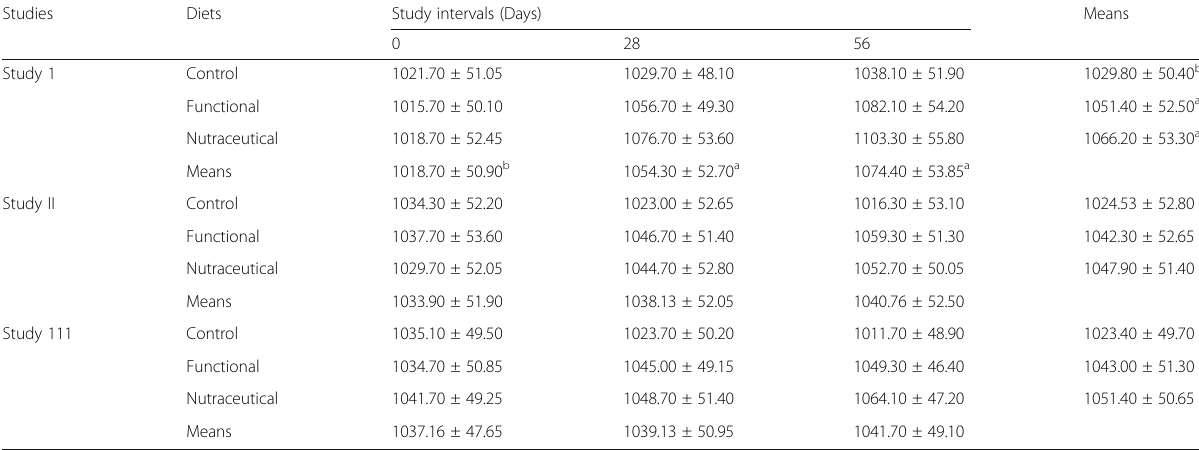
Table 10 Effect of diets and study intervals on platelets (10 3 / μ L) of rats in different studies